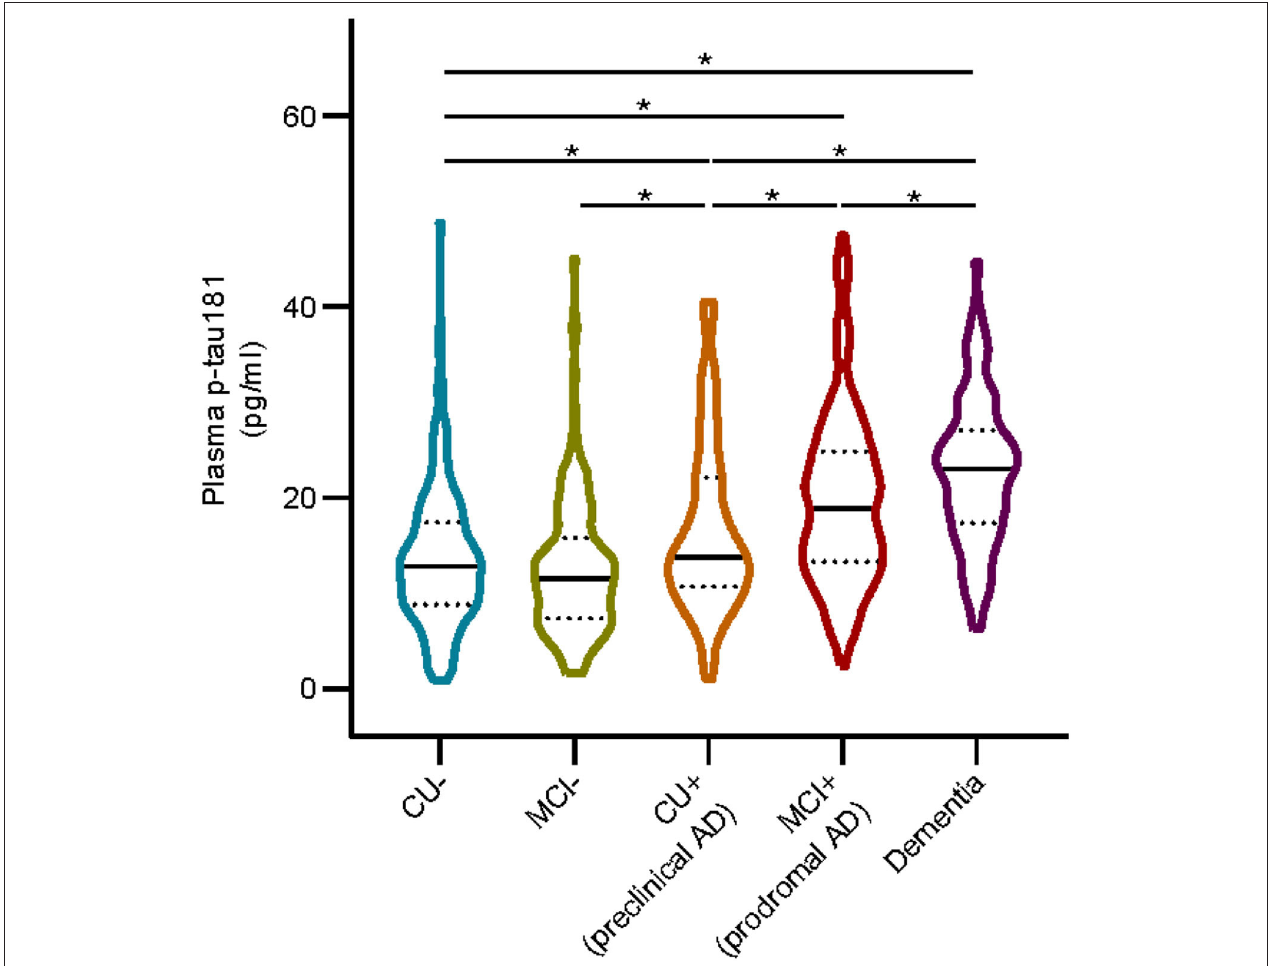
FIGURE 1 | Plasma p-tau 181 in different groups. Asterisk indicates a significant difference between groups ( p -value < 0.05, Mann–Whitney U test). CU–, cognitively unimpaired with negative A β ; MCI–, mild cognitive impairment with negative A β ; CU + , cognitively unimpaired with positive A β ; MCI + , mild cognitive impairment with positive A β